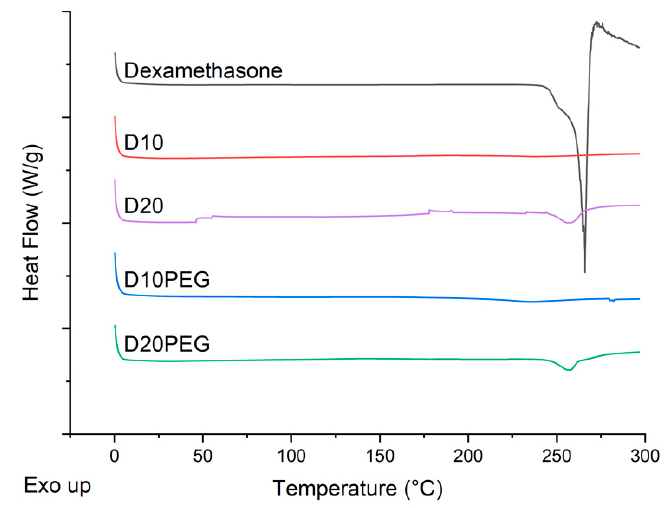
Figure 6. DSC scans of dexamethasone and DLP 3D printed formulations.